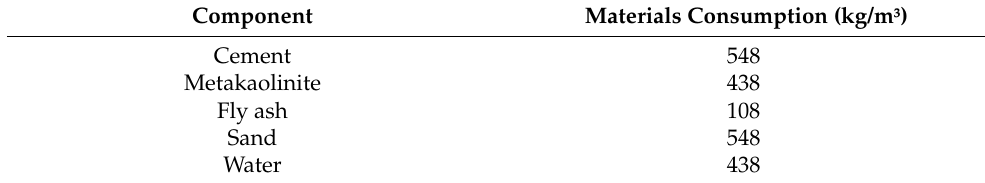
Table 2. Mix proportions of the mortar.